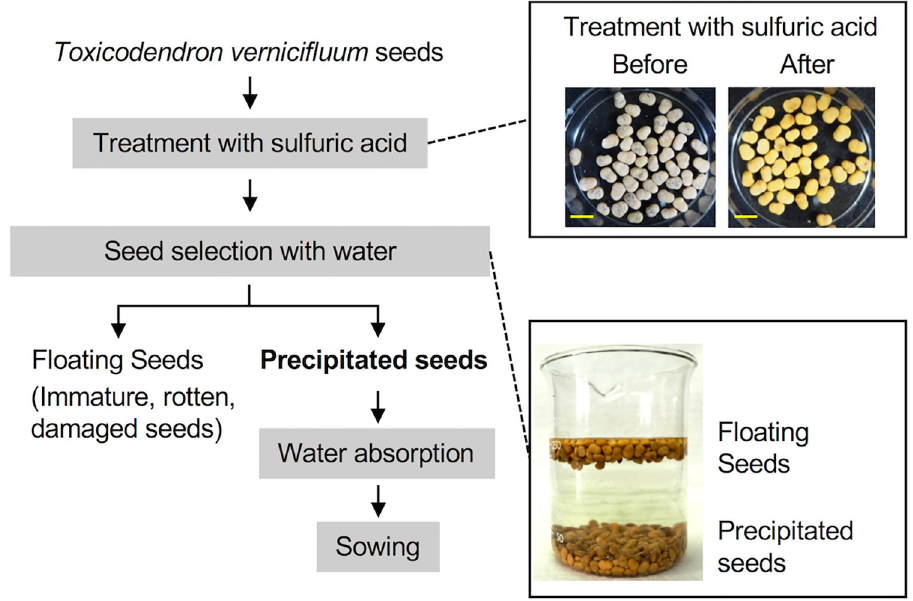
Fig 1. Schematic of seed preparation by conventional methods. Before sowing, the seeds are pretreated with sulfuric acid and then selected based on the differences in specific gravity. Photographs of the preparation process are shown. Scale bar = 1